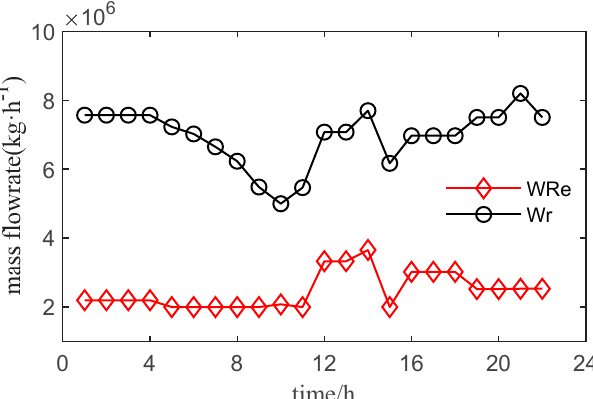
Figure 14. Trend chart of optimal operation parameters aiming at maximum GOR.